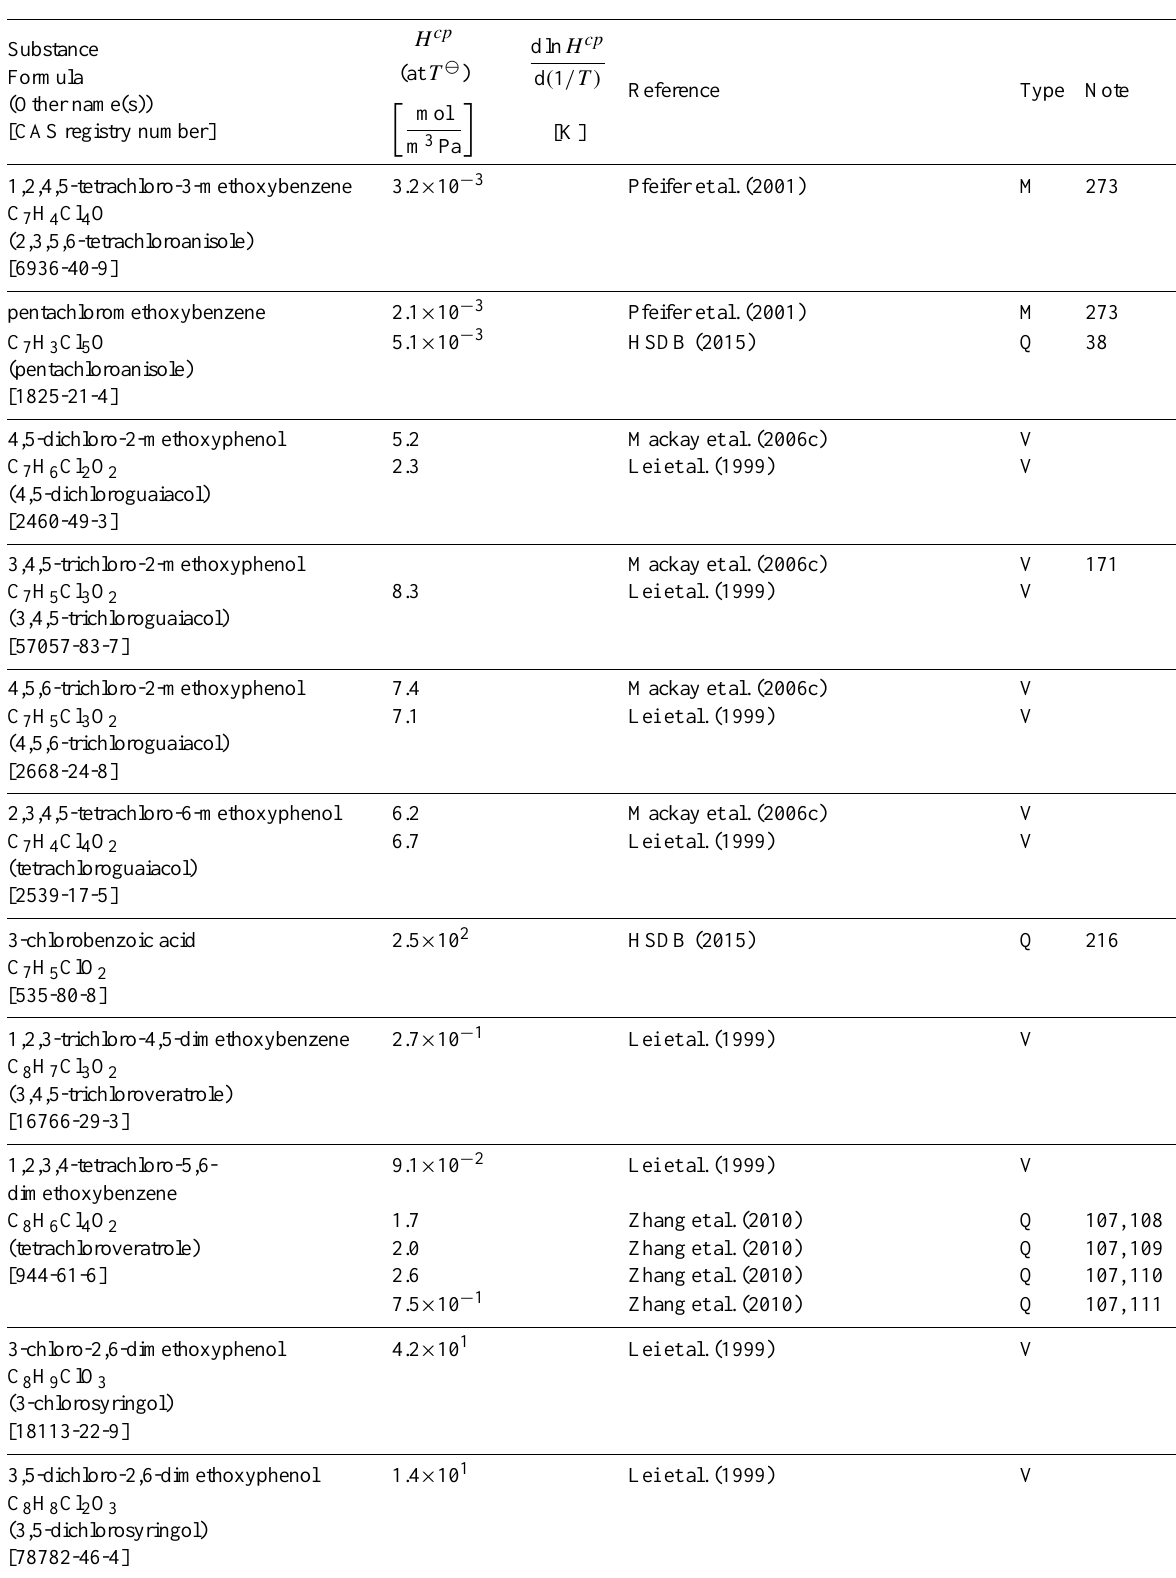
Table 6: Henry’s law constants for water as solvent